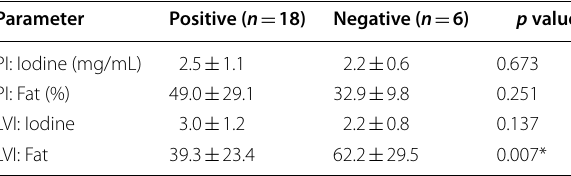
Data are mean SDs, * p < 0.05 (Mann–Whitney test) ±